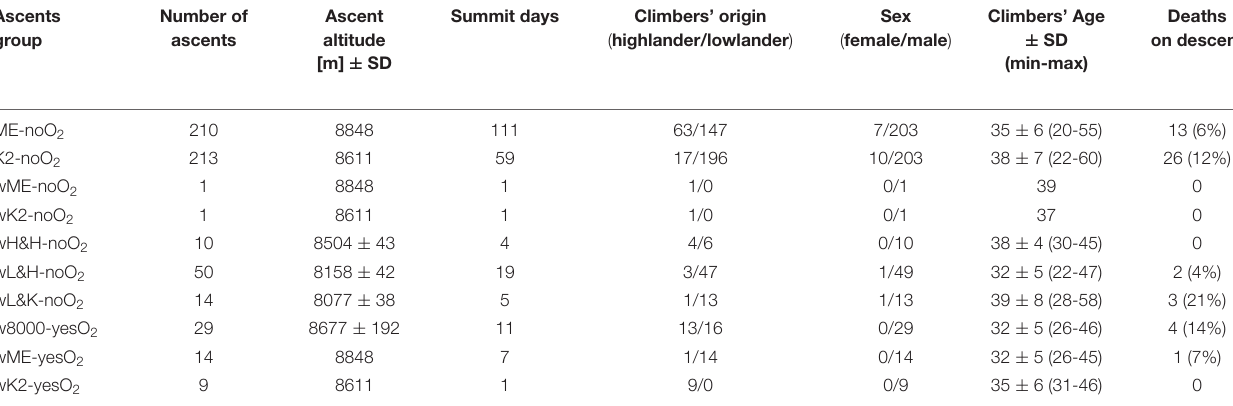
TABLE 1 | Characteristics of ascents of 8000 m peaks. Ascents